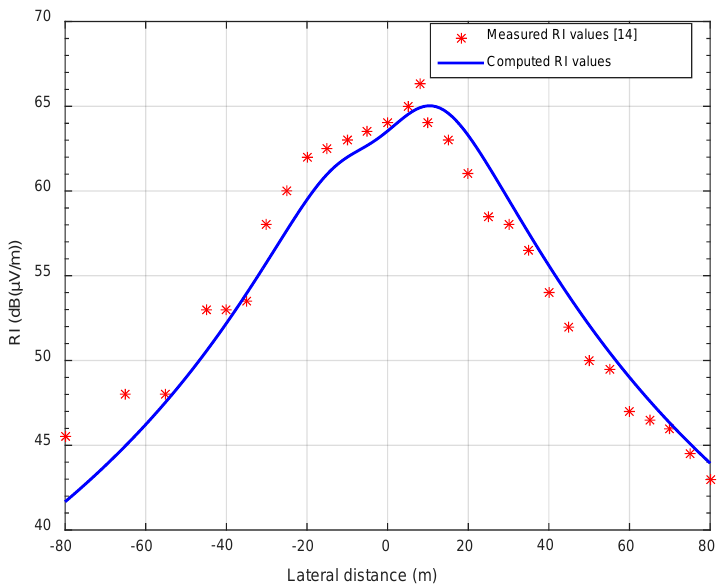
Figure 2. Comparison of measured [14] and computed radio interference (RI) profiles.